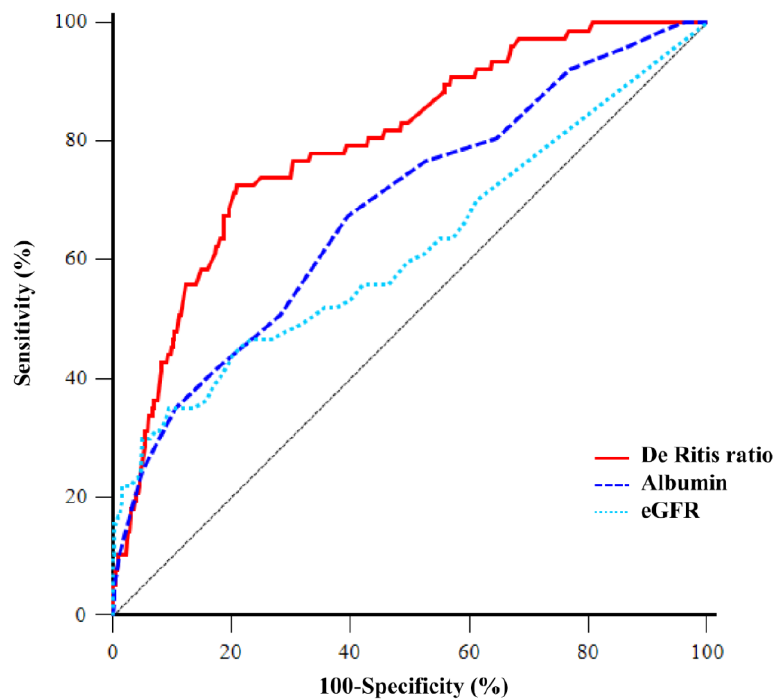
Figure 2. Comparison of ROC curve analyses of the De Ritis ratio at postoperative 1 day, preoperative serum albumin, and preoperative eGFR to predict AKI after RRP. The area under the ROC curve of the De Ritis ratio at postoperative day 1, preoperative serum albumin, and eGFR were 0.801, 0.685, and 0.619, respectively. ROC, receiver operating characteristic; eGFR, estimated glomerular filtration rate; AKI, acute kidney injury; RRP, radical retropubic prostatectomy.